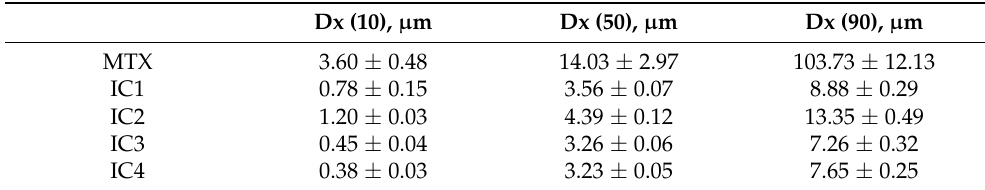
Table 3. The particle size of methotrexate-loaded inclusion compounds; MTX/HP- β -CD inclu- sion complex (IC1); MTX/ β -CD inclusion complex (IC2); MTX/M- β -CD inclusion complex (IC3); MTX/DM- β -CD inclusion complex